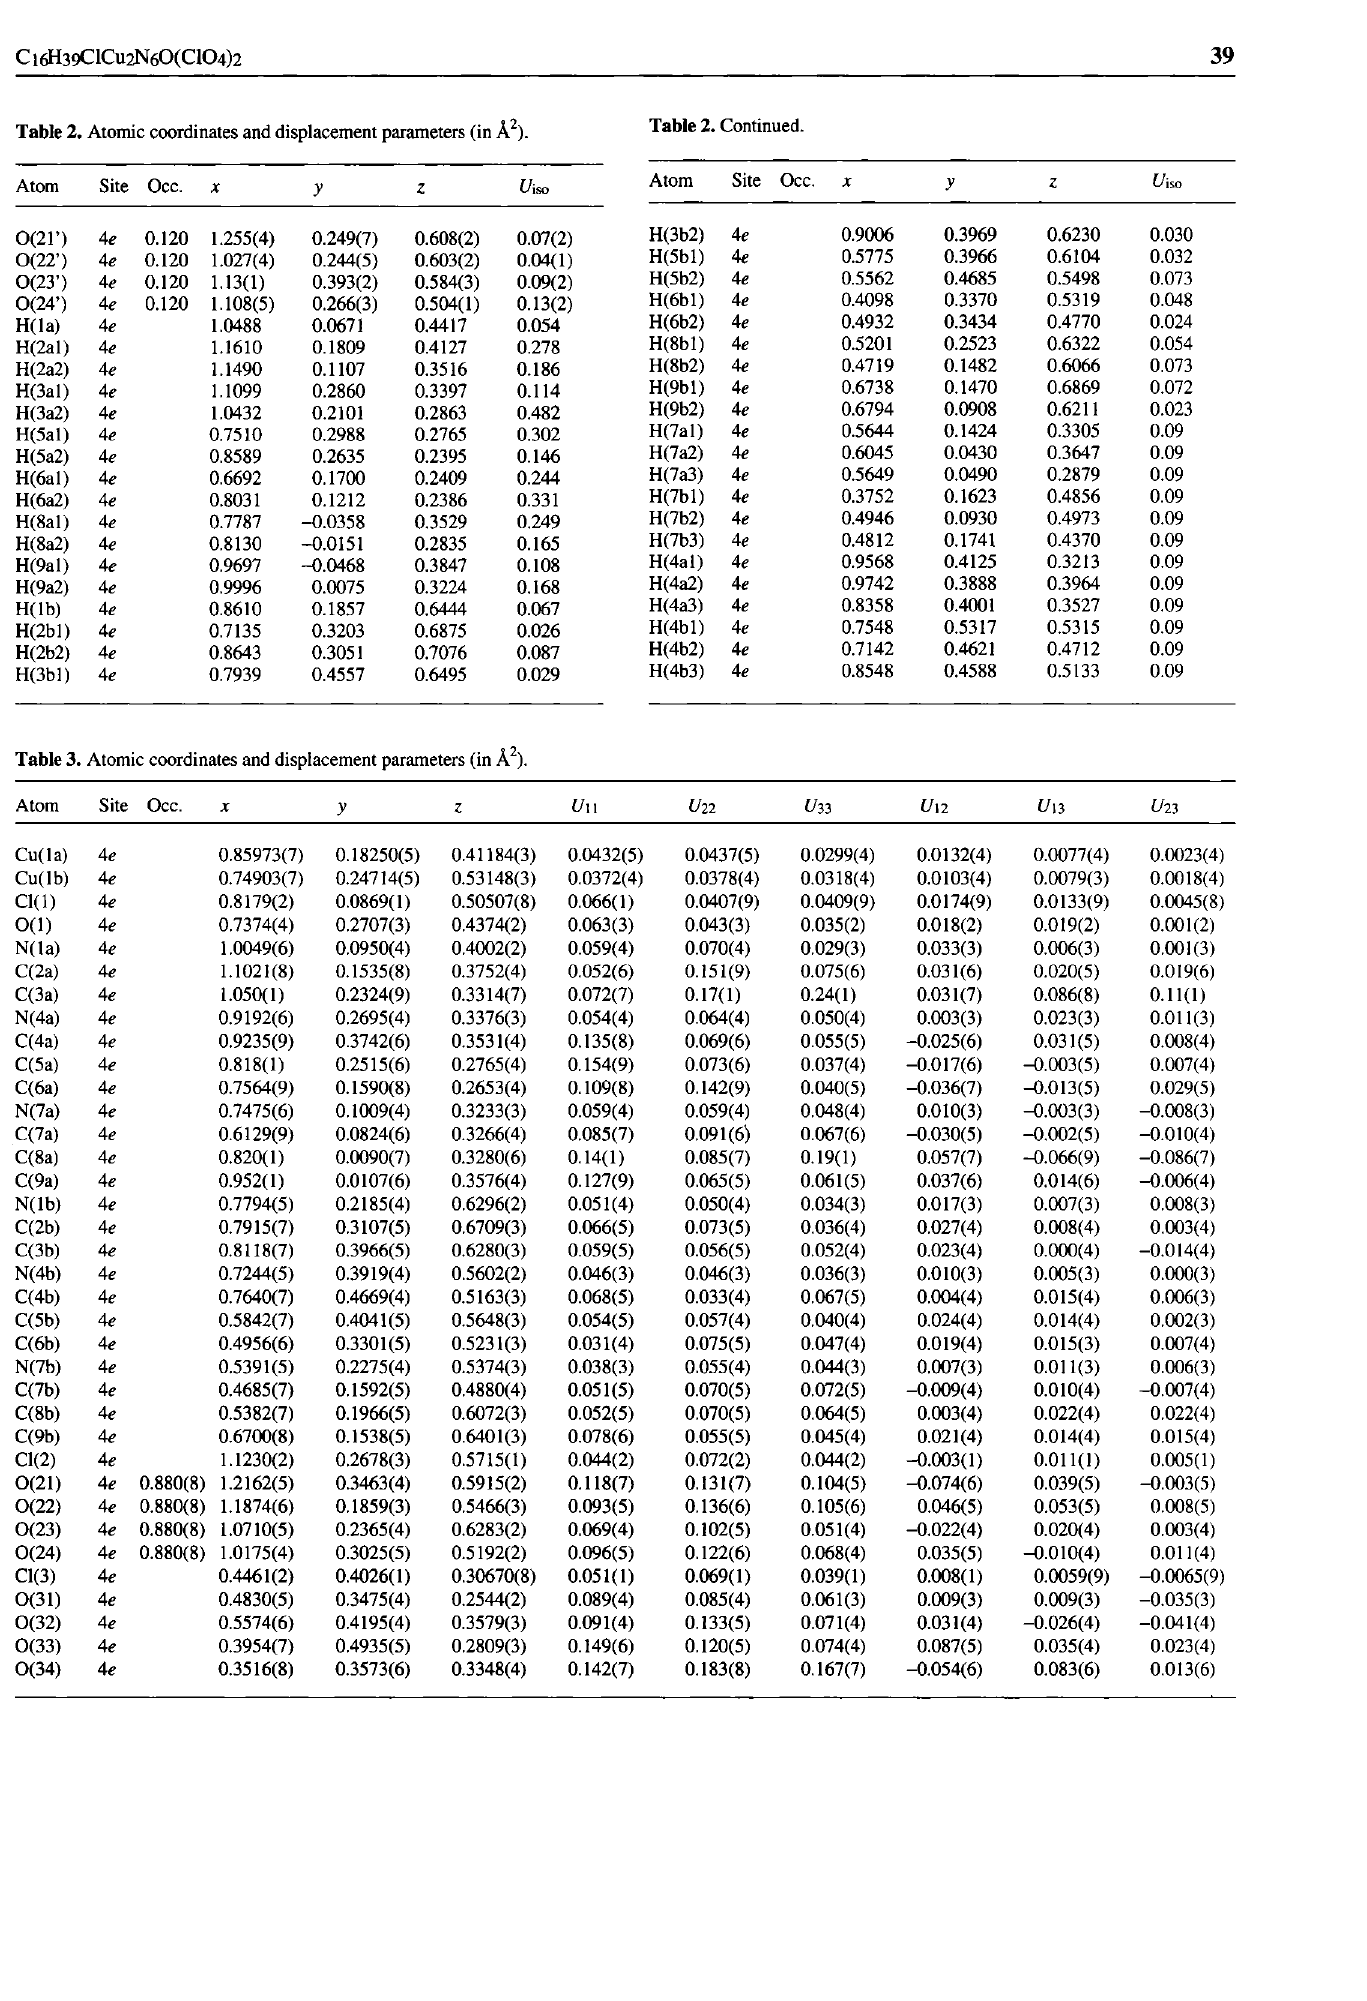
Table 2. Atomic coordinates and displacement parameters (in Â 2 ).